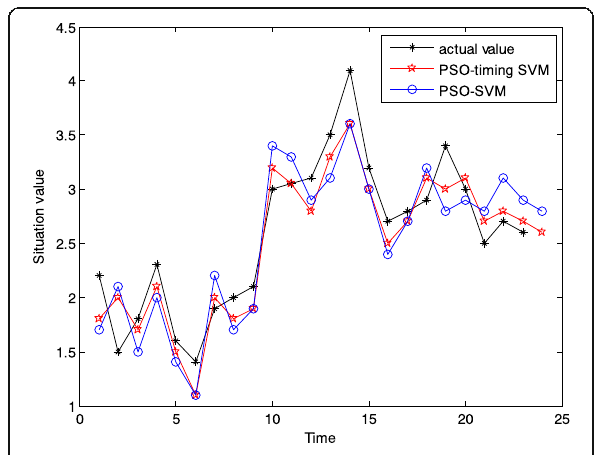
Fig. 4 Situation comparison of a certain day in June